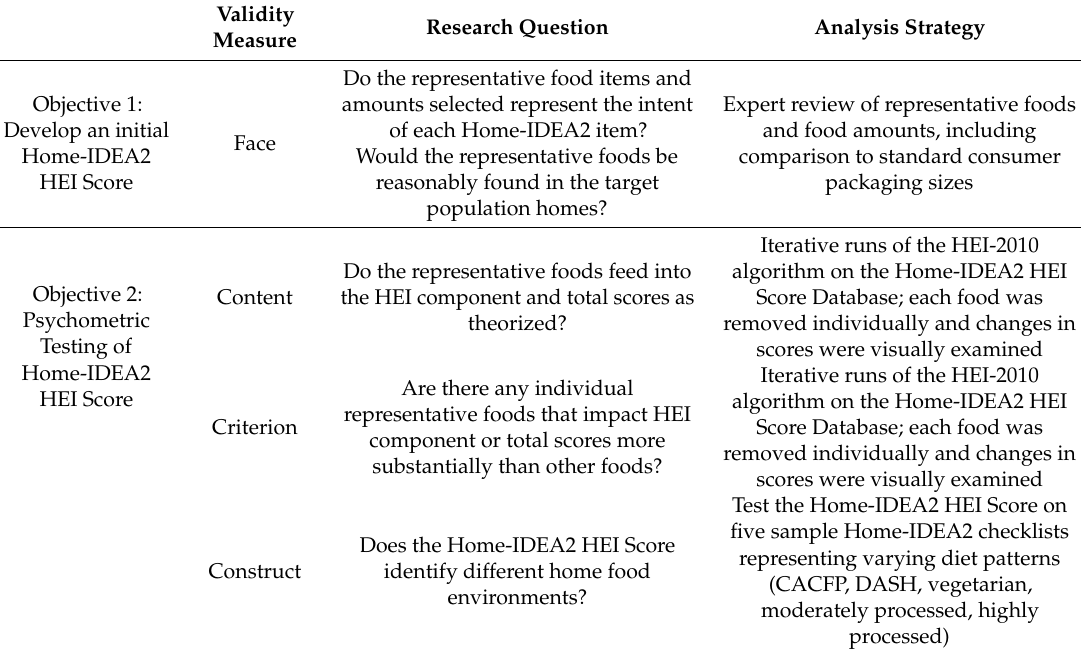
Table 3. Development and initial validation of Home-IDEA2 HEI